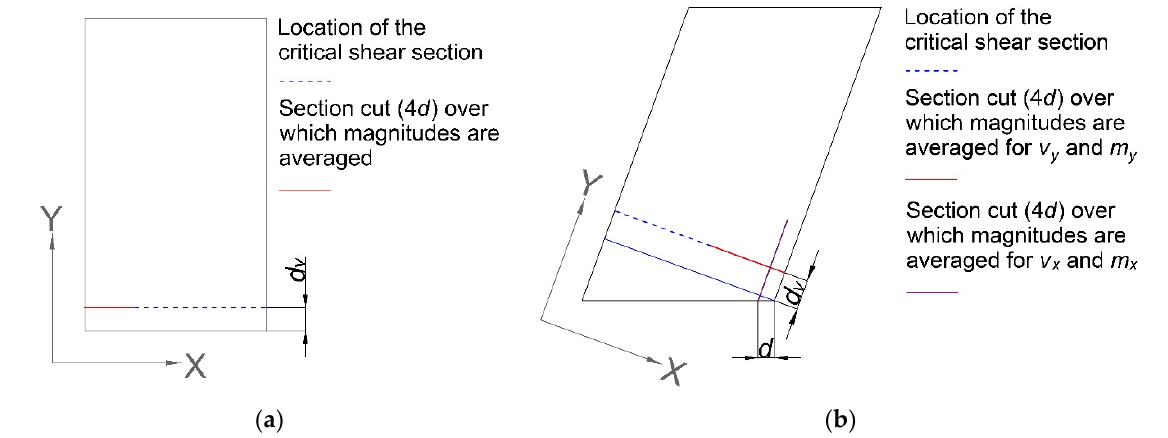
Figure 4. Shear section cuts for design. ( a ) Straight bridges and ( b ) skewed bridges.